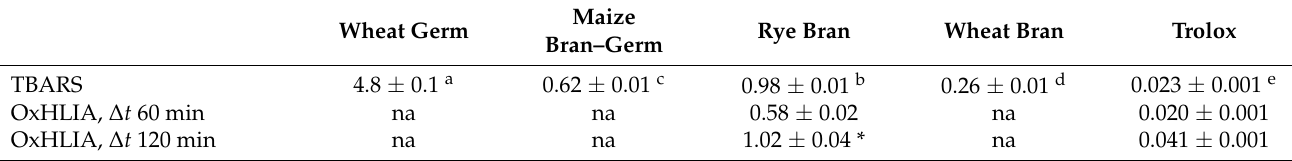
Table 6. Antioxidant activity (IC 50 values, mg/mL) of the cereal by-product hydroethanolic extracts. Maize Wheat Germ Rye Bran Wheat Bran Trolox Bran–Germ TBARS 4.8 ± 0.1